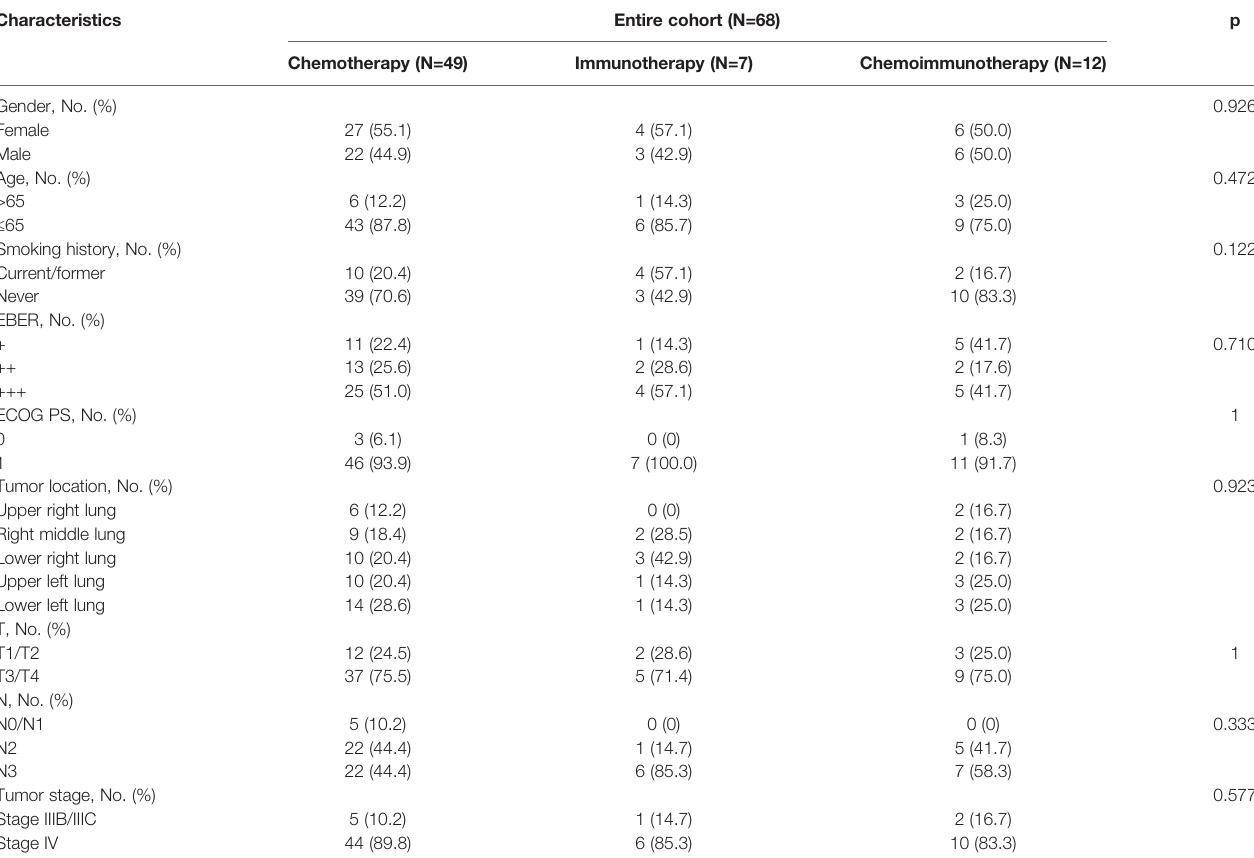
TABLE 1 | General clinicopathological characteristics of patients with different treatment methods.